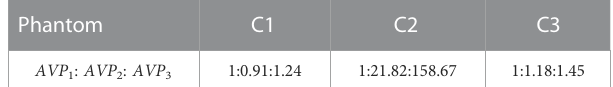
TABLE 5 Average pixel value ratio of the three tube solutions for imaging results in Part Ⅲ . Phantom C1 C2